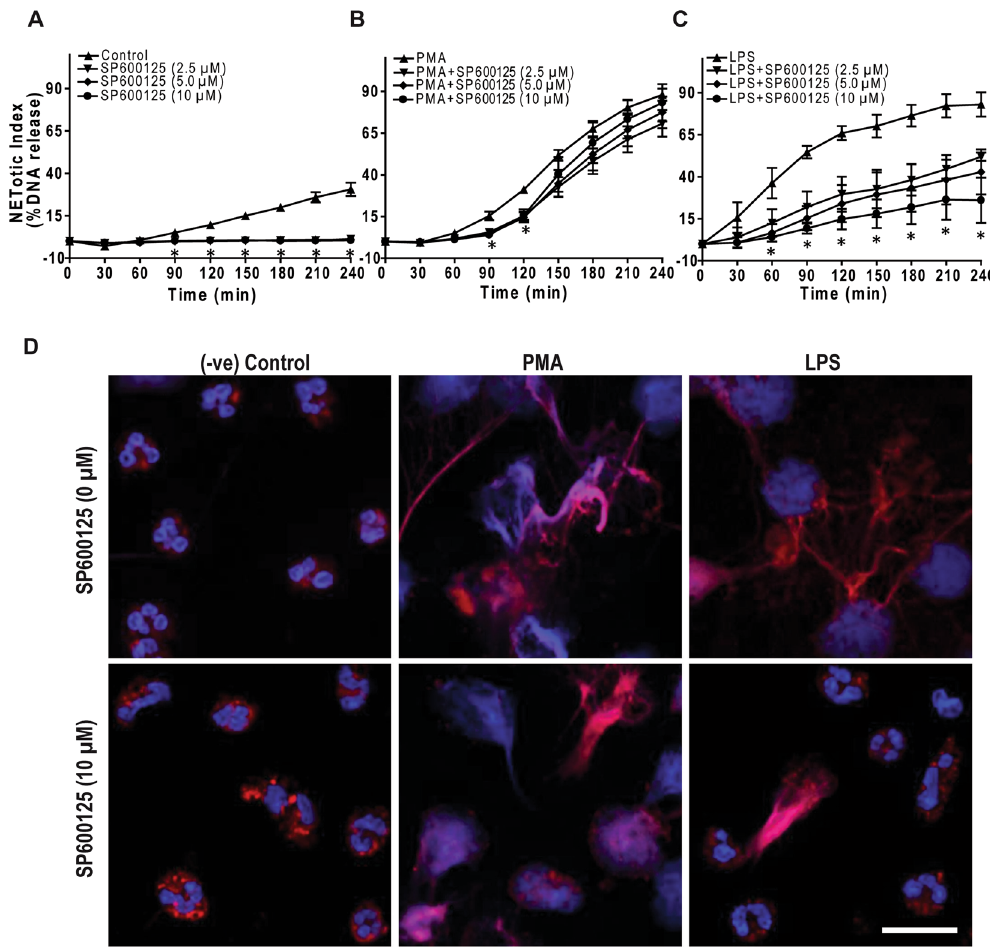
Figure 4. JNK inhibition by SP600125 suppresses LPS-mediated NETosis . ( A–C ) NETosis kinetics was assessed by Sytox Green plate reader assay after activation with 25 nM PMA and 25 μ g/ml LPS in the presence or absence of inhibitor. As shown in the %DNA release analysis, SP600125 (2.5, 5.0, 10 μ M) suppresses LPS mediated NETosis in a dosage-dependent manner, while not in PMA mediated NETosis (n = 3–4; * p value < 0.05; Two-way ANOVA with Bonferroni’s post test conducted at each time point). Error bars in all the panels represent SEM. ( D ) Neutrophils were activated by PMA and LPS with and without SP600125 for 4 hours, immunostained, and imaged for myeloperoxidase (MPO) and DNA. MPO is visible around the nuclei in media control with or without SP600125. MPO co-localizes to NET DNA generated by LPS, PMA, and PMA with SP600125. Neutrophils treated with LPS and SP600125 do not show NETosis, and the nuclear morphology of these cells remains the same as that of the unstimulated control neutrophils (Blue, DAPI staining for DNA; Red, MPO; n = 3; scale bar 20 μ m). See Supplementary Fig. S4 for low magnification